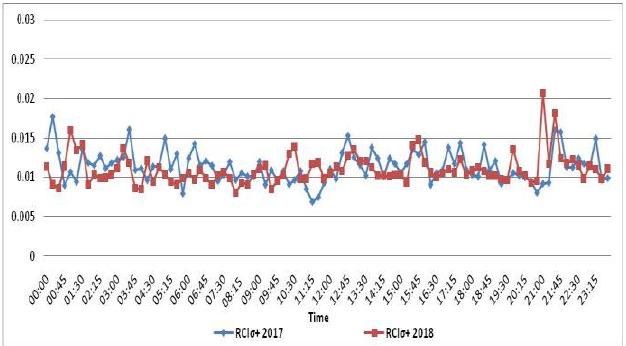
Figure 18. Comparison between ramping range values of power ramps in 15 min interval at each observation time t for the years 2017 and